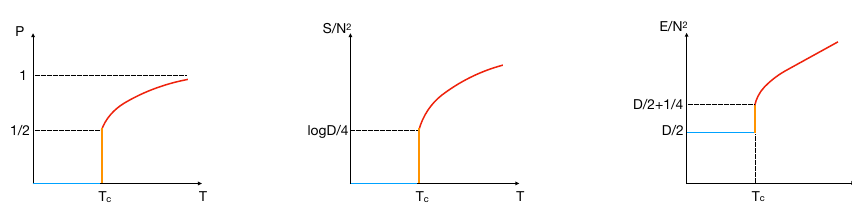
Figure 9 . Sketches of the temperature dependence of the Polyakov loop P , entropy S and energy E in the gauged Gaussian matrix model (5.25). Blue, orange and red lines are identified with the confined, partially deconfined and completely deconfined phases, respectively. These figures are taken from ref.